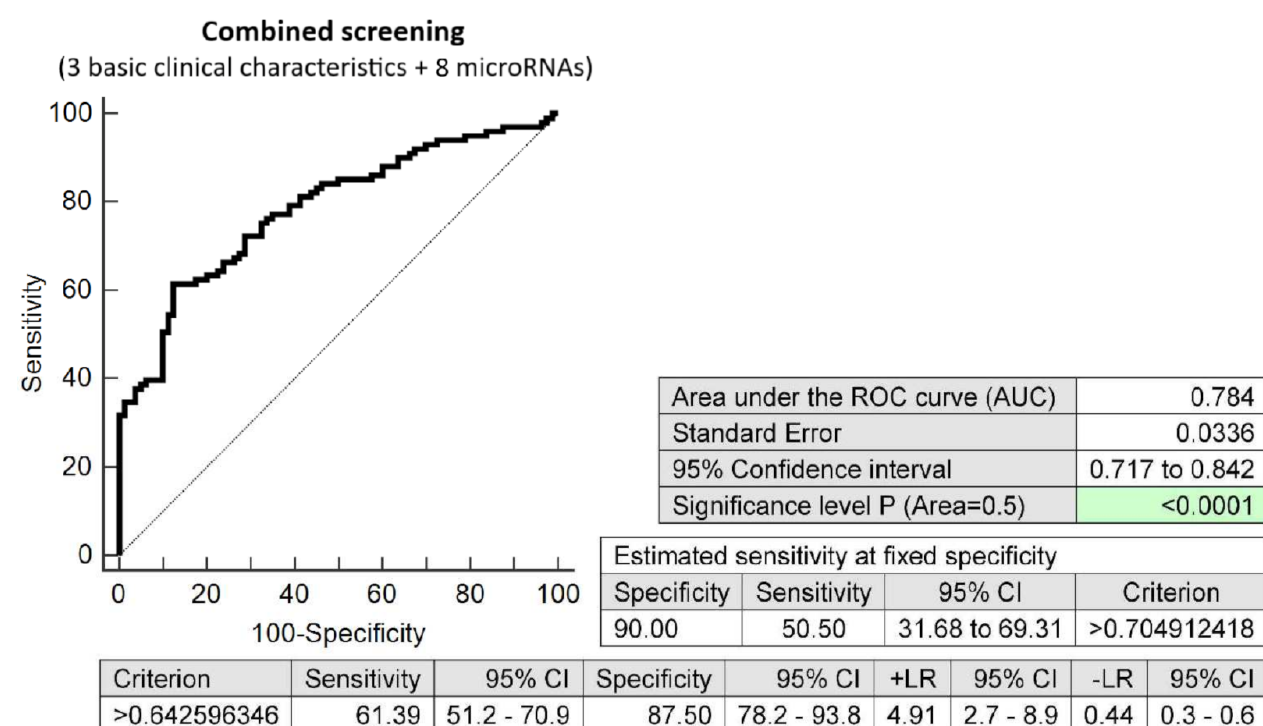
Figure 9. ROC analysis—the combination of 3 basic clinical characteristics (maternal age and BMI values at early stages of gestation and an infertility treatment by assisted reproductive technology) and 8 dysregulated microRNA biomarkers (miR-1-3p, miR-20a-5p, miR-20b-5p, miR-100-5p, miR- 125b-5p, miR-195-5p, miR-499a-5p, and miR-574-3p). At a 10.0% FPR, 50.50% pregnancies destinated to develop GDM managed by diet only were identified during the first trimester of gestation. This represents 51 out of 101 pregnancies correctly predicted to develop GDM and 8 out of 80 normal pregnancies predicted false positively to develop